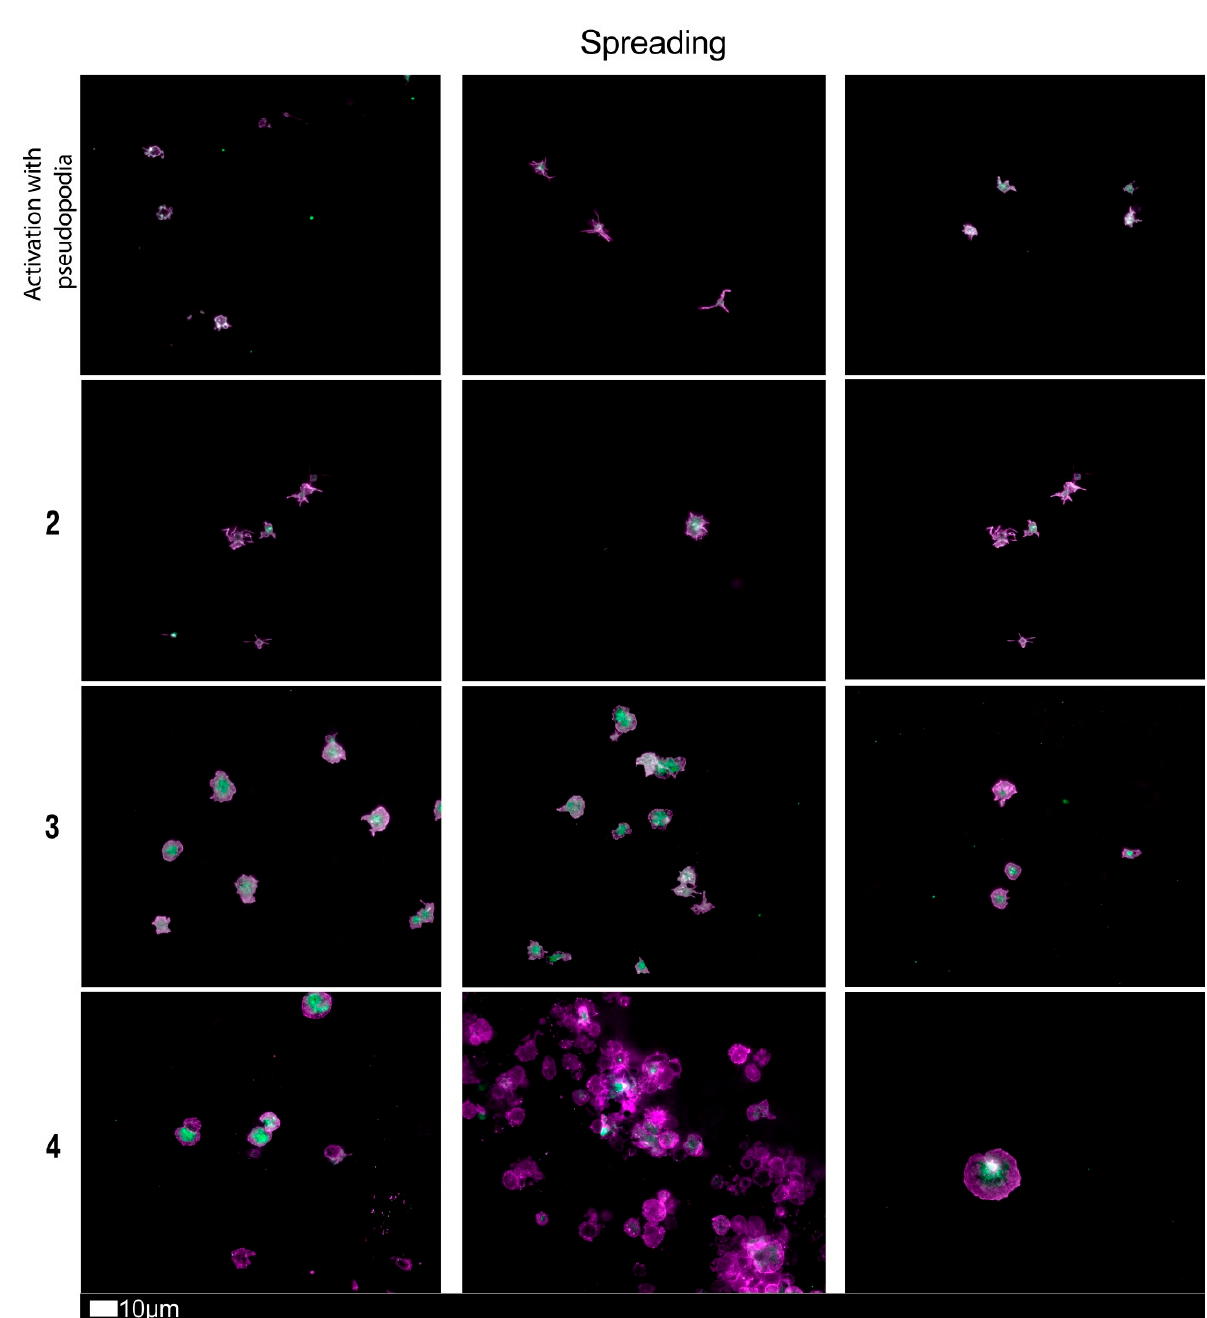
sentative examples of the different stages of different stages of microclot formation. Stage 1 shows